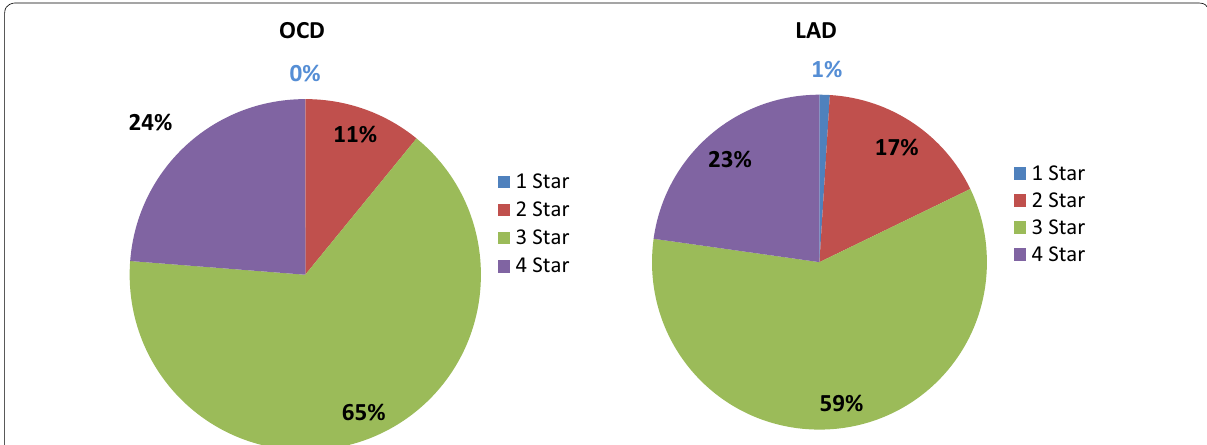
Fig. 1 Pie chart showing the distribution of QCS scores among patients with LAD versus OCD